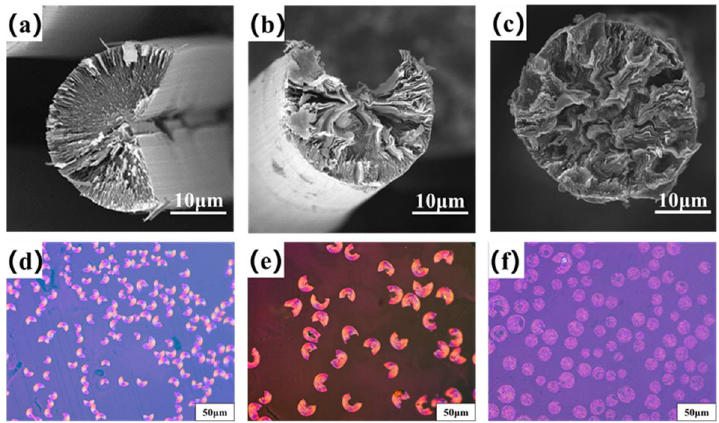
Figure 6. SEM images and POM photos of B0−MP−CF−3000 ( a , d ), B1−MP−CF−3000 ( b , e ) and B5−MP−CF−3000 ( c , f ).